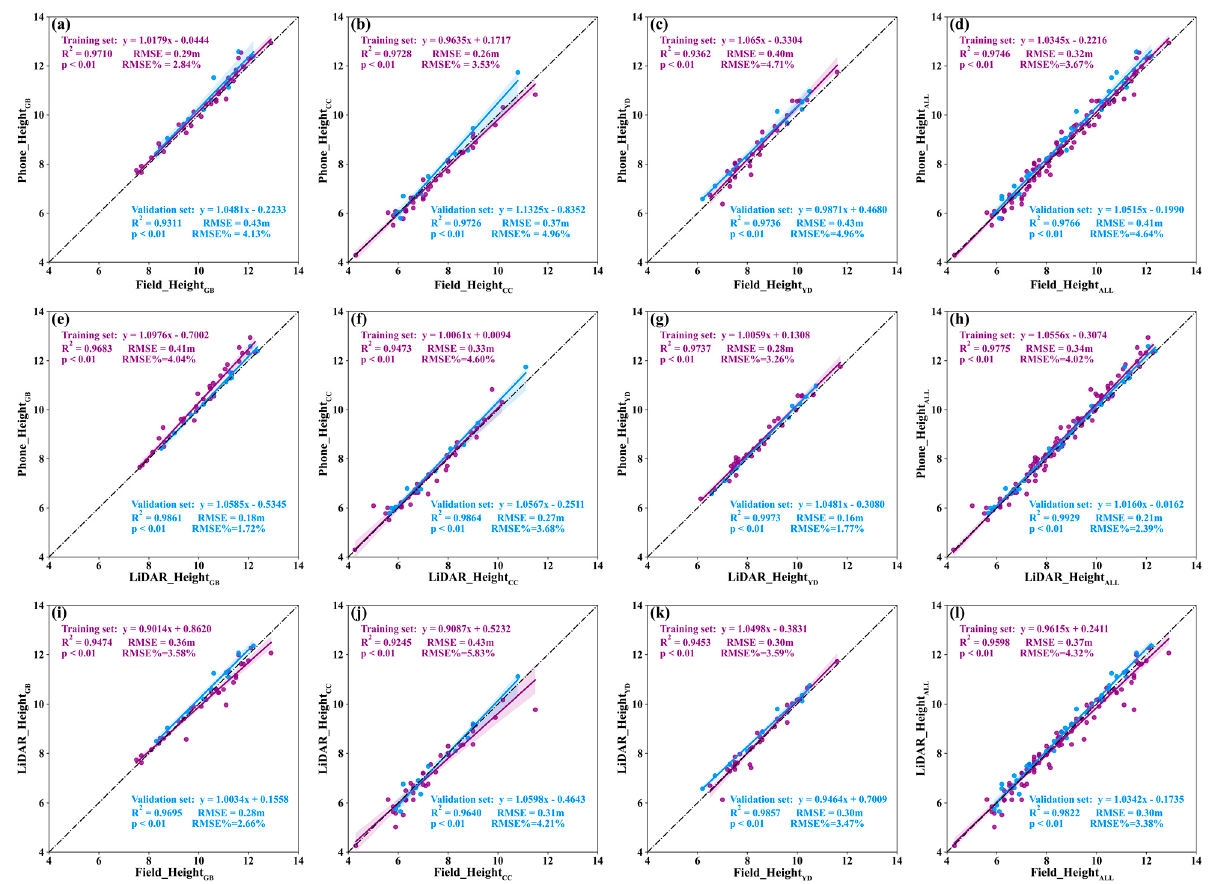
Figure 10. Correlation during the Field_Height, Phone_Height and LiDAR_Height. Among them, the purple points represent the training set and the blue points represent the validation set. ( a – d ) Correlation between the Field_Height and the Phone_Height for three tree species. ( e – h ) Correlation between the LiDAR_Height and the Phone_Height for three tree species. ( i – l ) Correlation between the Field_Height and the LiDAR_Height for three tree species.